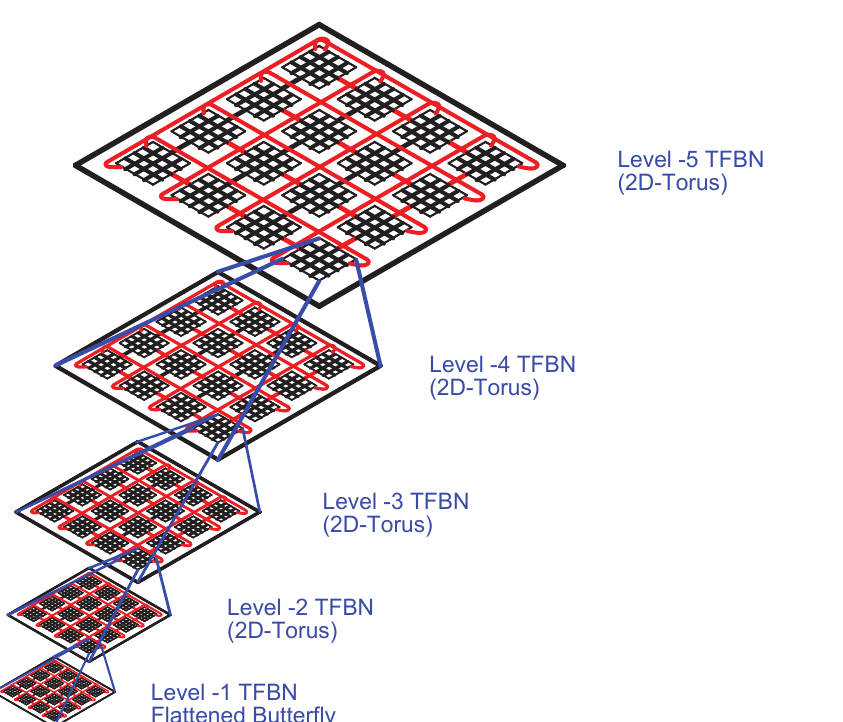
Figure 2. A 4 × 4 higher level network of a TFBN. A total of 5 levels can be interconnected with 4 × 4 basic